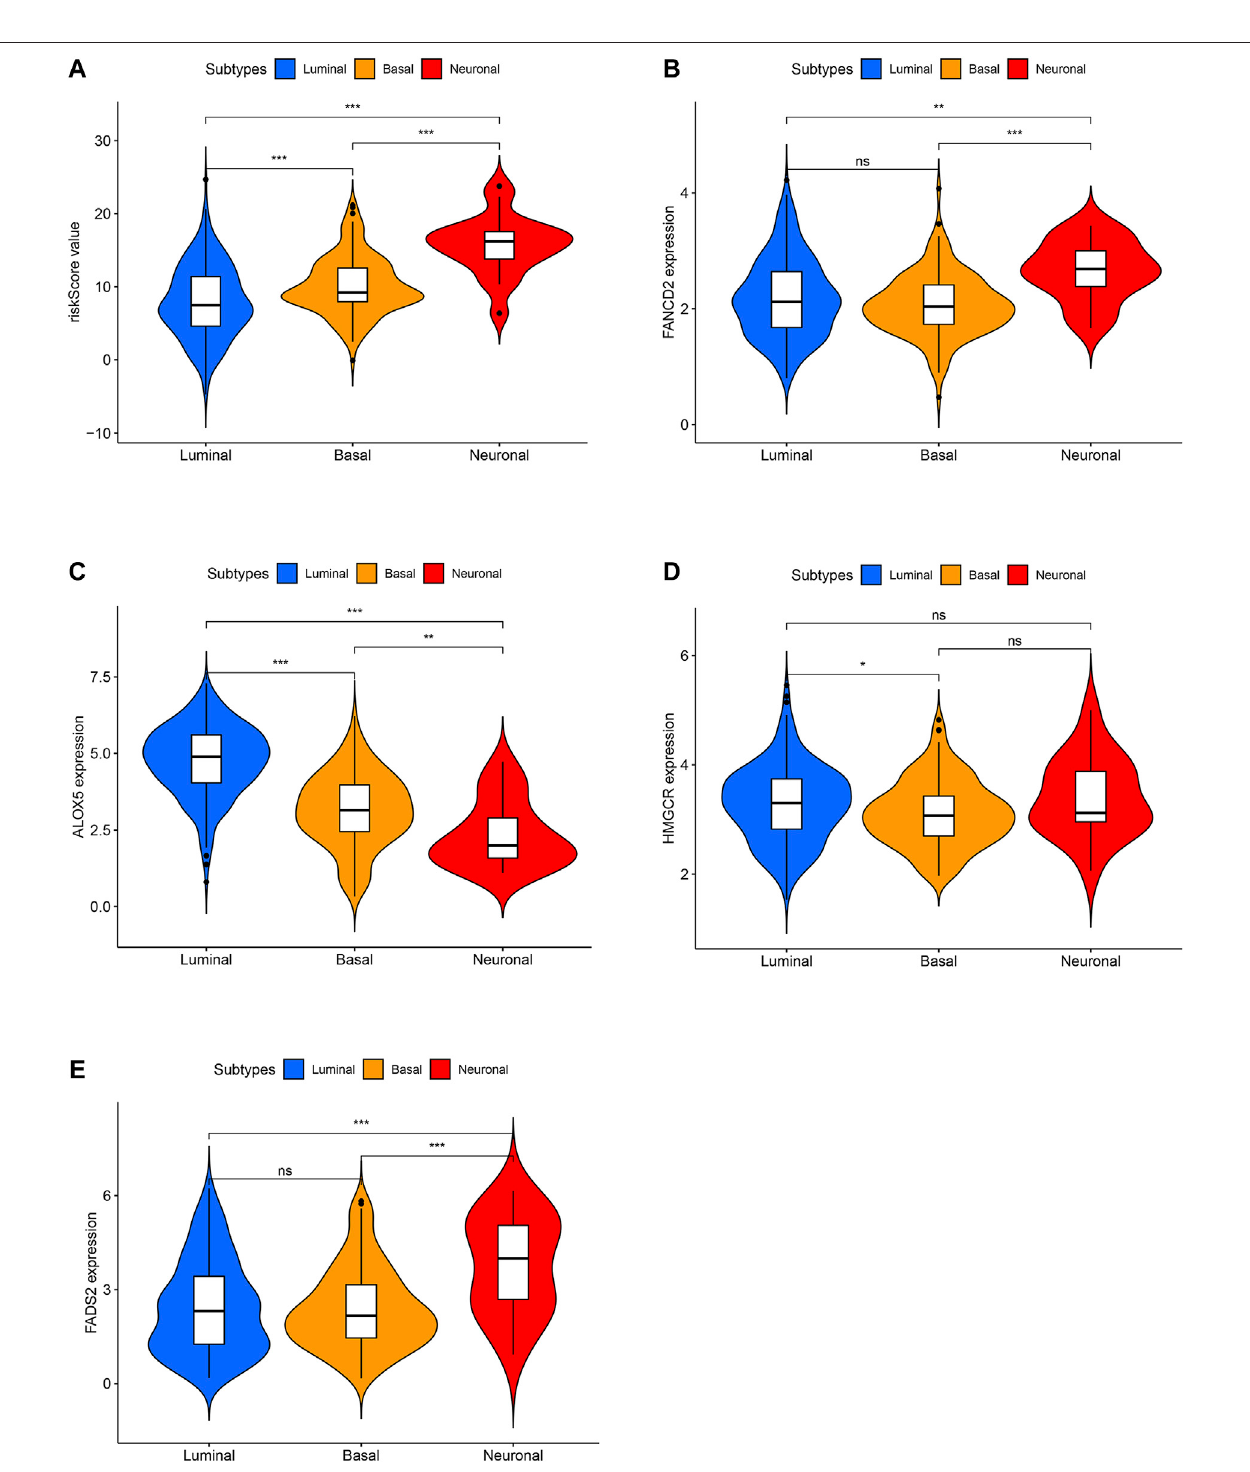
FIGURE 5 | The difference analysis for risk scores between different molecular subtypes in TCGA cohort. (A) The difference analysis for risk scores between differentmolecularsubtypes. (B) ThedifferenceanalysisforFANCD2expressionbetweendifferentmolecularsubtypes. (C) ThedifferenceanalysisforALOX5expression between different molecular subtypes. (D) The difference analysis for HMGCR expression between different molecular subtypes. (E) The difference analysis for FADS2 expression between different molecular subtypes.